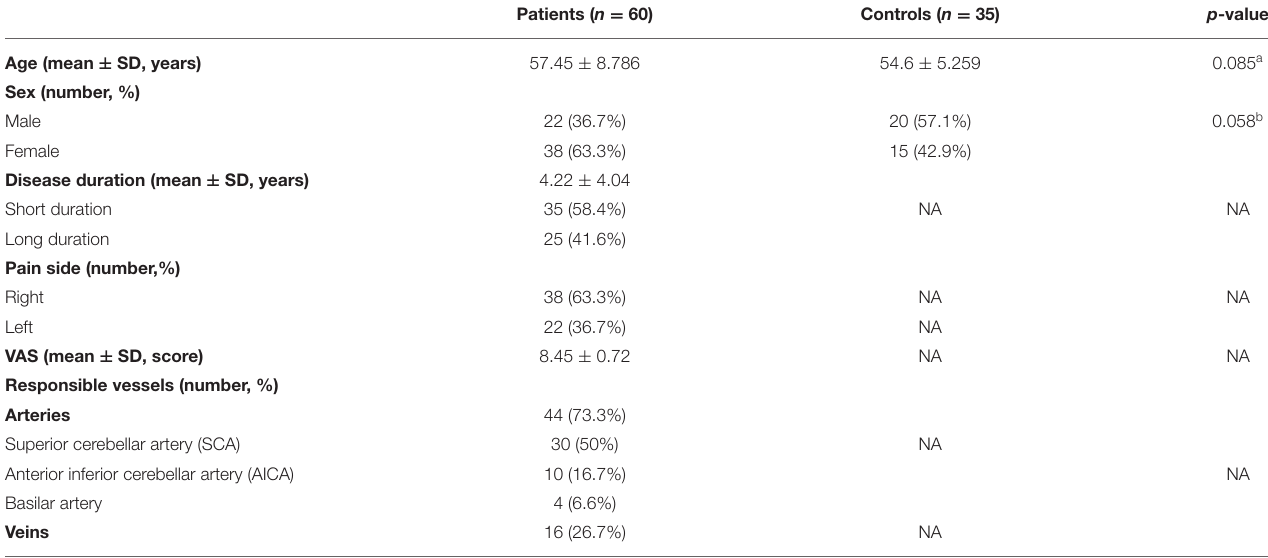
TABLE 1 | Demographic and disease characteristics of participants.